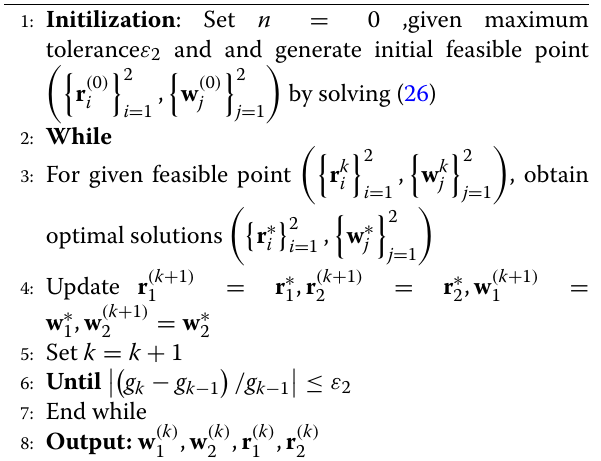
Algorithm 2 Energy Efficiency Maximization Iteration Algorithm with fixed α